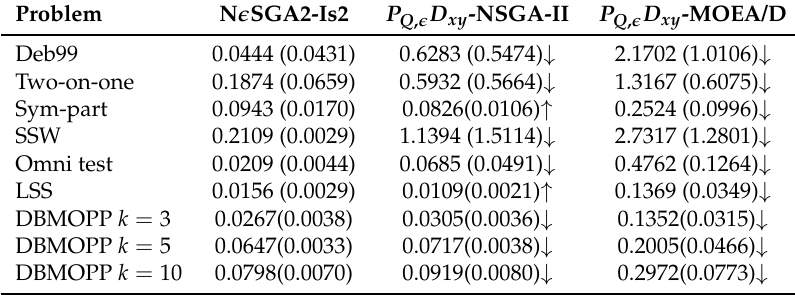
Table 7. Averaged ∆ 2 in objective space for the comparison of the state-of-the-art